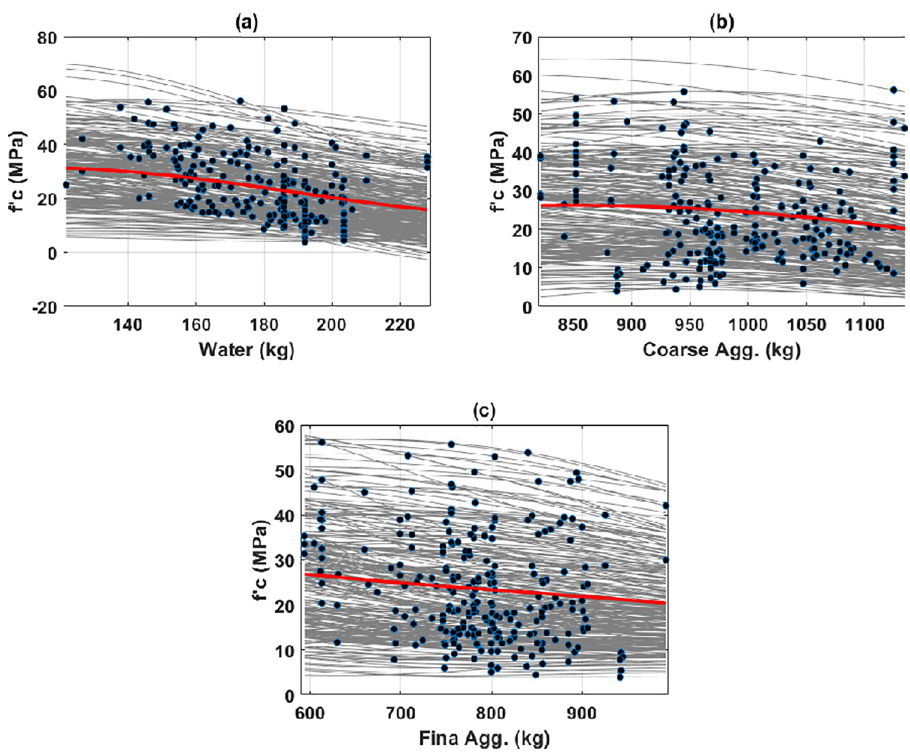
Table 3. PDP investigation of the compressive strength in function of different inputs and the corresponding effects, rank. Inputs Input variation PDP Compressive Effect Rank strength variation Min Max Min Max | Δ | Cement 102 540 10.28 42.24 31.96 Positive 1 BFS 0 359.4 21.81 31.10 9.29 Positive 5 FA 0 174.7 23.76 26.16 2.4 Positive 8 Water 121.8 228 15.75 31.23 15.48 Negative 3 Superplasticizer 0 32.2 21.06 32.12 11.06 Positive 4 Coarse Agg. 822 1134 20.17 26.17 6.0 Negative 7 Fine Agg. 594 945 20.38 26.86 6.48 Negative 6 Age 1 14 14.42 34.37 19.95 Positive 2